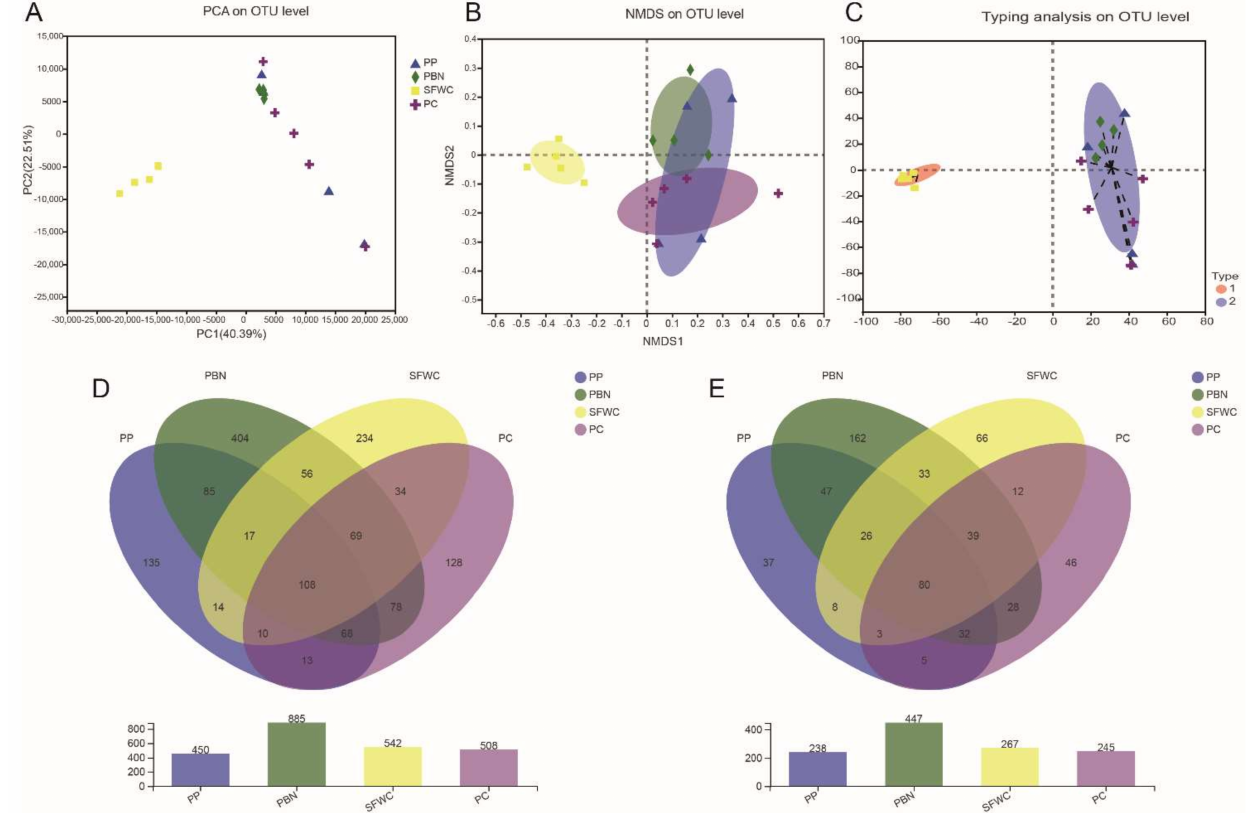
Figure 3. Beta diversity and Venn diagrams of bacterial community of four traditional fermented vegetables. ( A ) Principal component analysis (PCA). ( B ) nonmetric Multidimensional Scaling (NMDS). ( C ) bacterial classification plot. Venn diagrams at OTU ( D ), genus level ( E ) according to bacterial